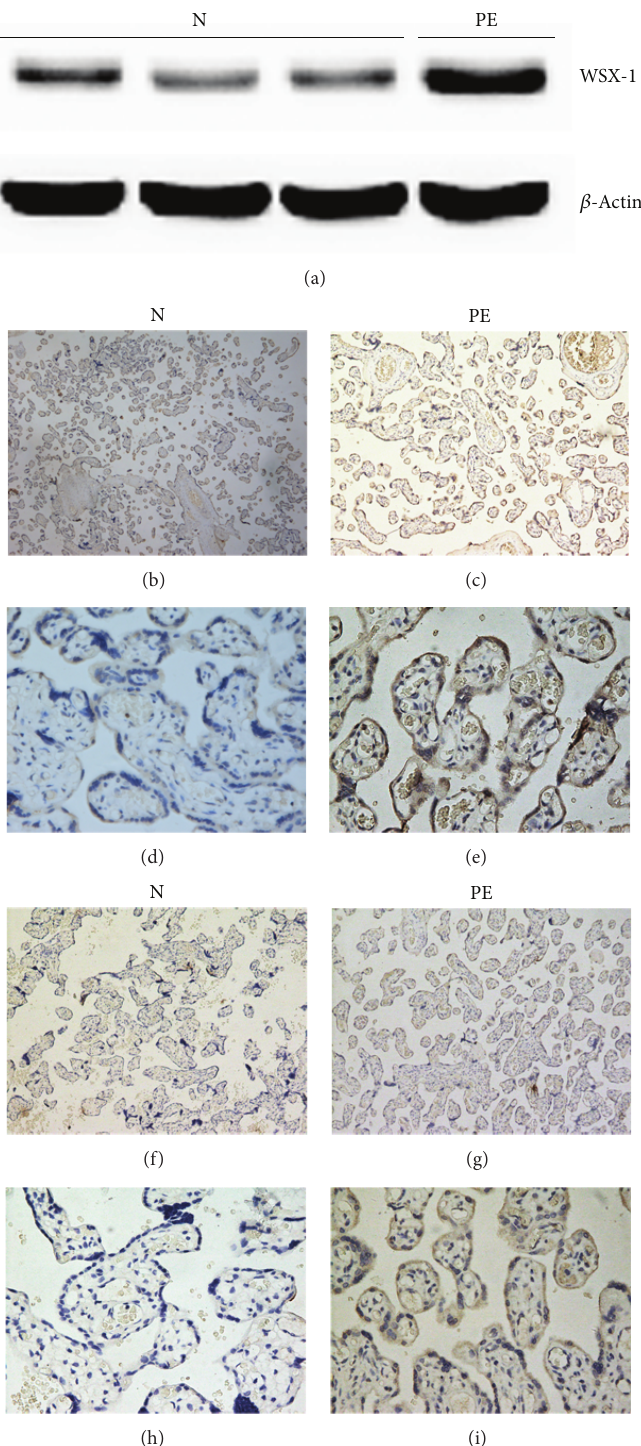
Figure 2: Analysis of IL-27 and IL-27 receptor expression in placental tissues. (a) Representative Western blot analysis of IL-27 receptor subunits WSX-1 in placental tissues. The first three are representative of samples of normal pregnancy (N) group and the last is from the PE group. (b)–(i) Immunohistochemical staining of IL-27 and WSX-1 in the placental tissues. (b) and (d) show the immunostaining of IL-27 in normal control (N) group; (c) and (e) show the immunostaining of IL-27 in preeclampsia (PE) group. (f) and (h) show the immunostaining of the WSX-1 in normal control (N) group; (g) and (i) show the immunostaining of WSX-1 in preeclampsia (PE) group. 𝛽 -Actin was used as protein control to ensure an equal amount of loaded protein. Original magnification: 100x for c, f, g, and h; 400x for d, e, h, and i. All experiments were performed in three independent